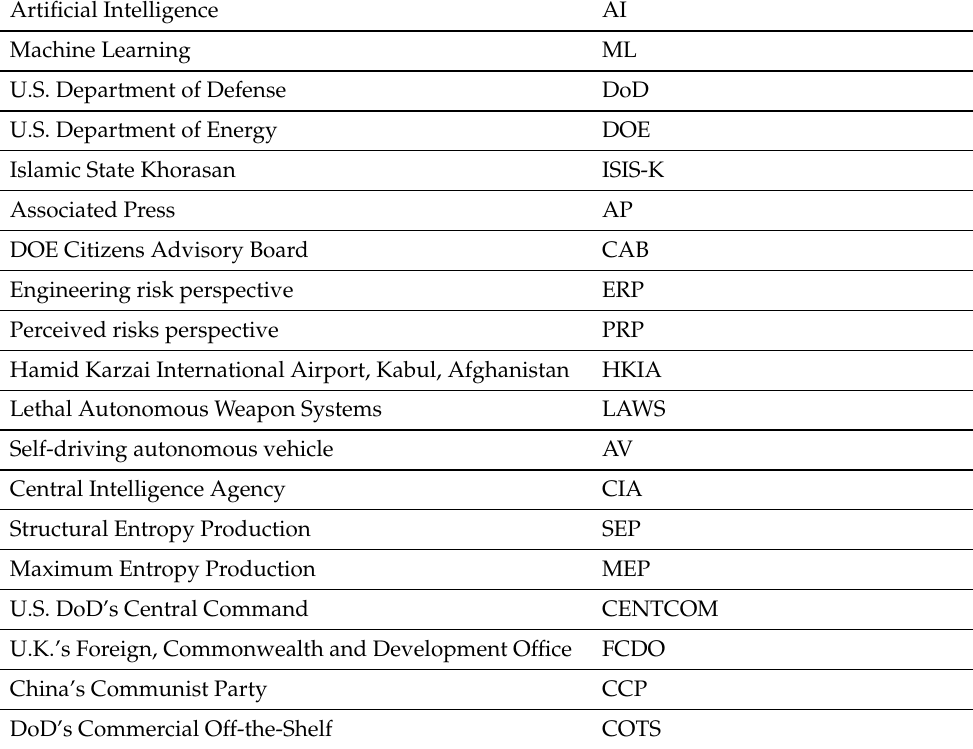
Table 1. A list of